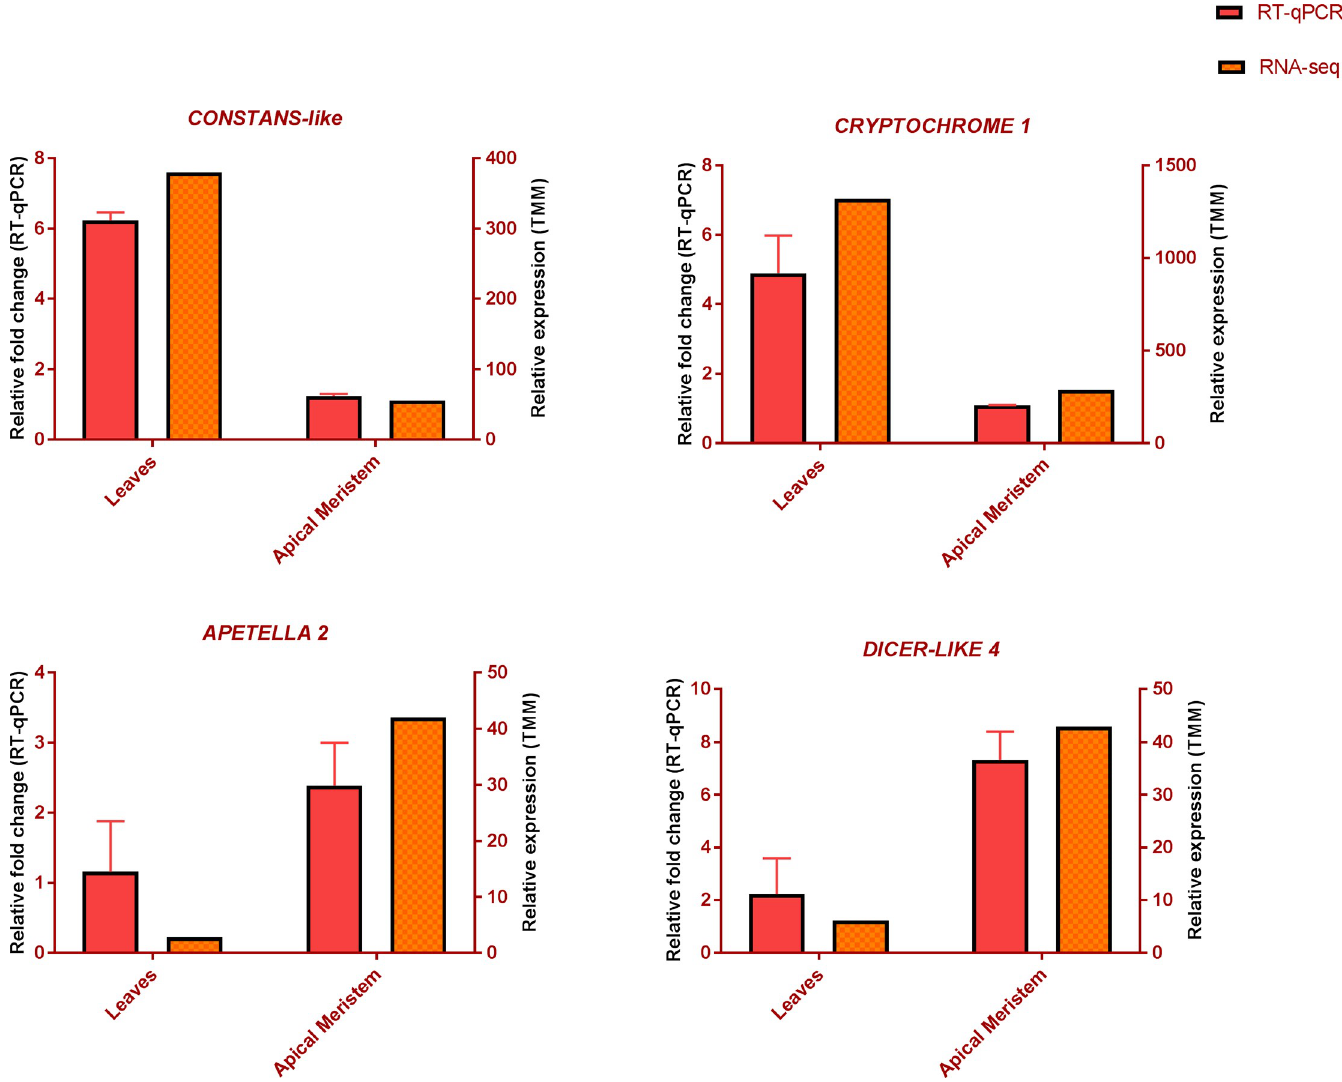
Fig 7. Relative expression of the flowering-pathway genes CONSTANS-LIKE , CRYPTOCHROME , APETELA 2 , and DICER-LIKE 4 across leaves and apical meristems. Expression profile is based on RNA-seq data, normalised by the TMM method and RT-qPCR data showing relative fold change, normalised to the selected reference genes. The RT-qPCR experiment was performed using three biological replicates for each tissue with three technical replicates ±